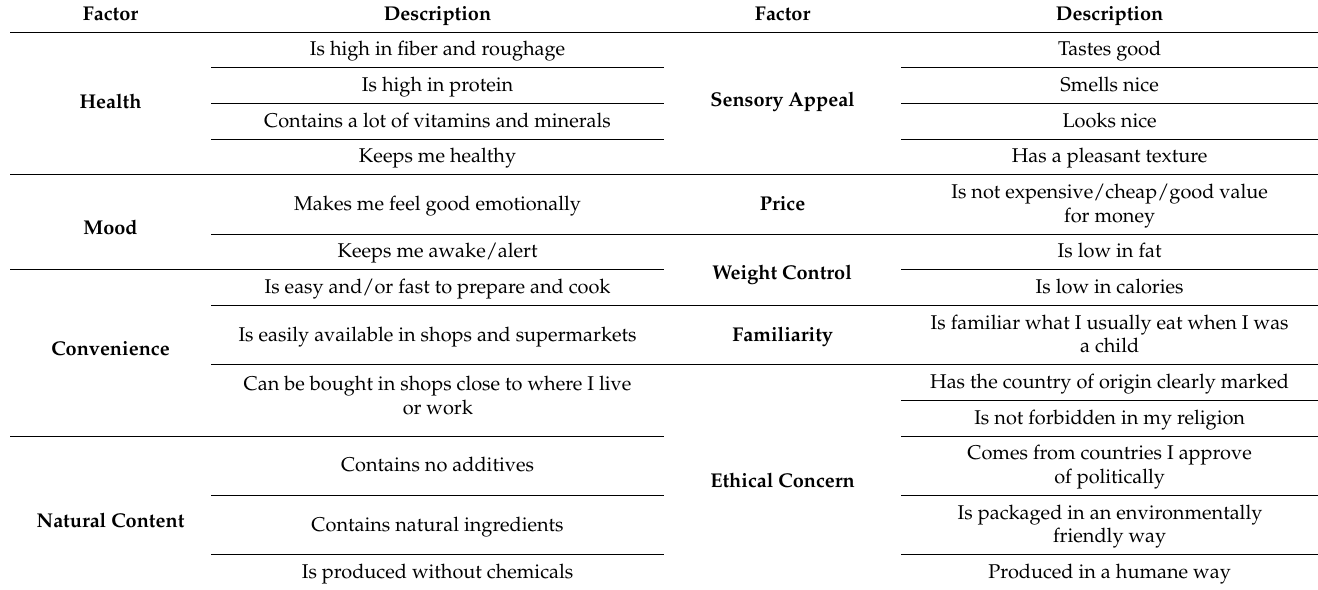
Table A2. Food choice questionnaires: “It is important to me that the food I eat on a typical day”. 1 = Not at all important, 2 = Slightly important, 3 = Neither unimportant nor important, 4 = Fairly important, 5 = Very